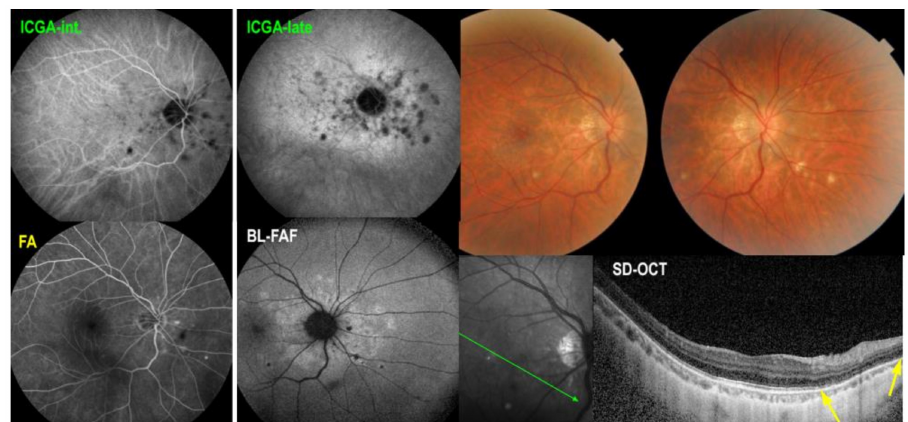
Figure 3. Multimodal imaging signs in MFC. The ICGA ( top two left frames) show numerous hypofluorescent dots in the intermediate angiographic phase, ( top left ) much better visualized in the late phase frame (ICGA-late). Some hypofluorescent lesions correspond also to the cicatricial lesions visible as hyperfluorescent punctiform spots on fluorescein angiography ( bottom left ). The BL-FAF picture ( bottom middle ) shows hyperautofluorescent areas corresponding to active lesions characterized by loss of photoreceptor outer segments shown on SD-OCT ( bottom right , between two yellow arrows).